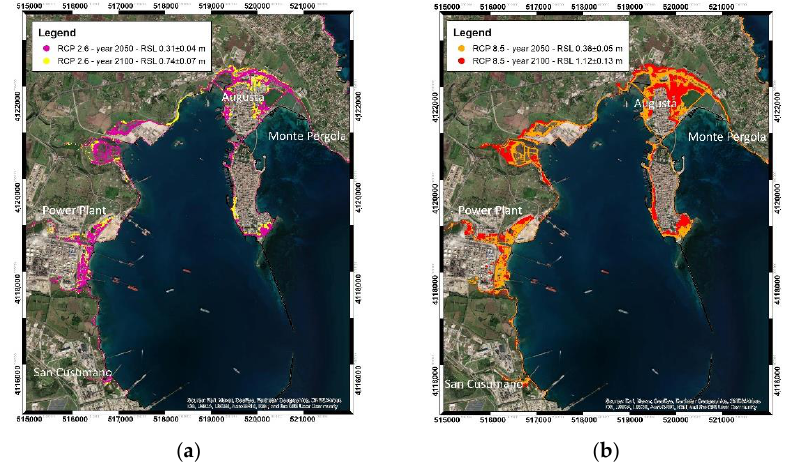
Figure 11. The bay of Augusta. In colors are reported the expected extension of land flooding in